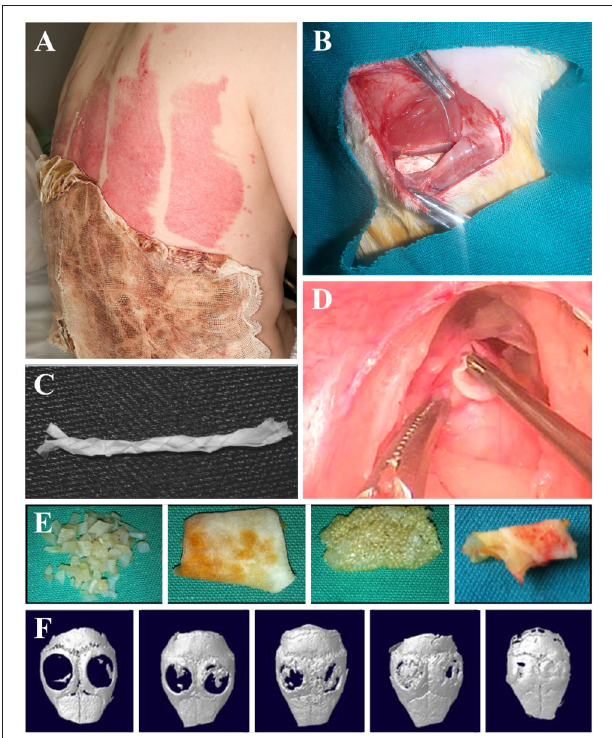
FIGURE 6 | Applications of cellulose biomaterials. (A) Skin, (B) nerve, (C) tendon/ligament, (D) larynx, (E) cartilage, (F) bone. (A) (Hakkarainen et al., 2016 ), Copyright 2016. Reproduced with permission from Elsevier Inc. (B) (Naseri-Nosar et al., 2017), Copyright 2017. Reproduced with permission from Elsevier Inc. (C) ( Mathew et al., 2013), Copyright 2013. Reproduced with permission from John Wiley and Sons. (D) ( De Souza et al., 2011), Copyright 2011. Reproduced with permission from Elsevier Inc. (E) (Guler et al., 2015), Copyright 2015. Reproduced with permission from John Wiley and Sons. (F) ( Park S. et al., 2015) Copyright 2015. Reproduced with permission from Elsevier